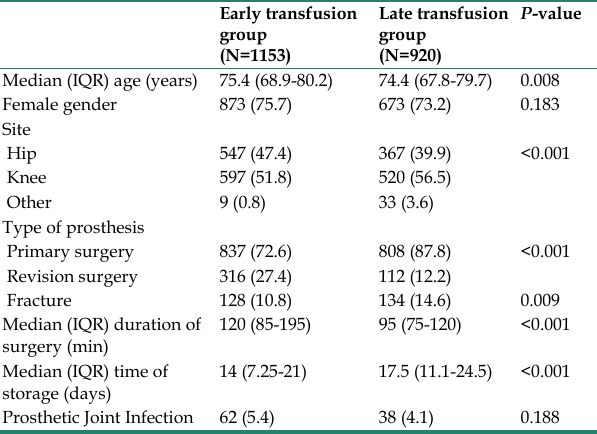
Table 1. Baseline characteristics of patients according to the group of patients transfused during surgery or within the first 6 hours after surgery (early transfusion group) and group of patients transfused between 6 and 96 hours after surgery (late transfusion group).